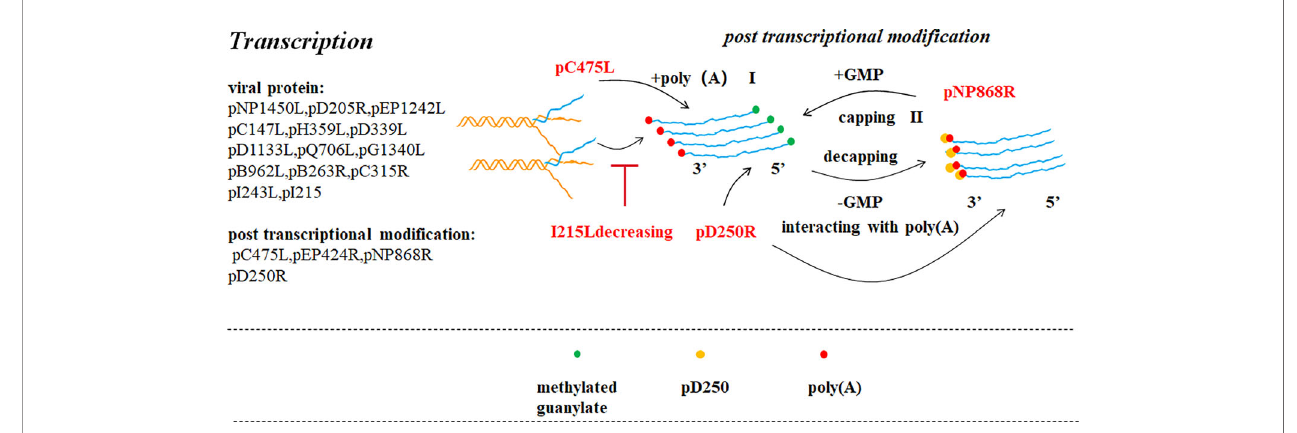
FIGURE 4 | ASFV transcription and post-transcriptional modi fi cation (39). Pre-mRNA obtained after ASFV transcription is modi fi ed in the cytoplasm by capping the 5 ’ end (II) and poly adenylating the 3 ’ end (I). ASFV encodes a polyadenosine enzyme (pC475L) that may be involved in 3 ’ end modi fi cation. ASFV pNP868R participates in 5 ’ end modi fi cation. Ba71V D250R encodes a decapping protein (ASFV-DP), which could interact with poly(A) of the 3 ’